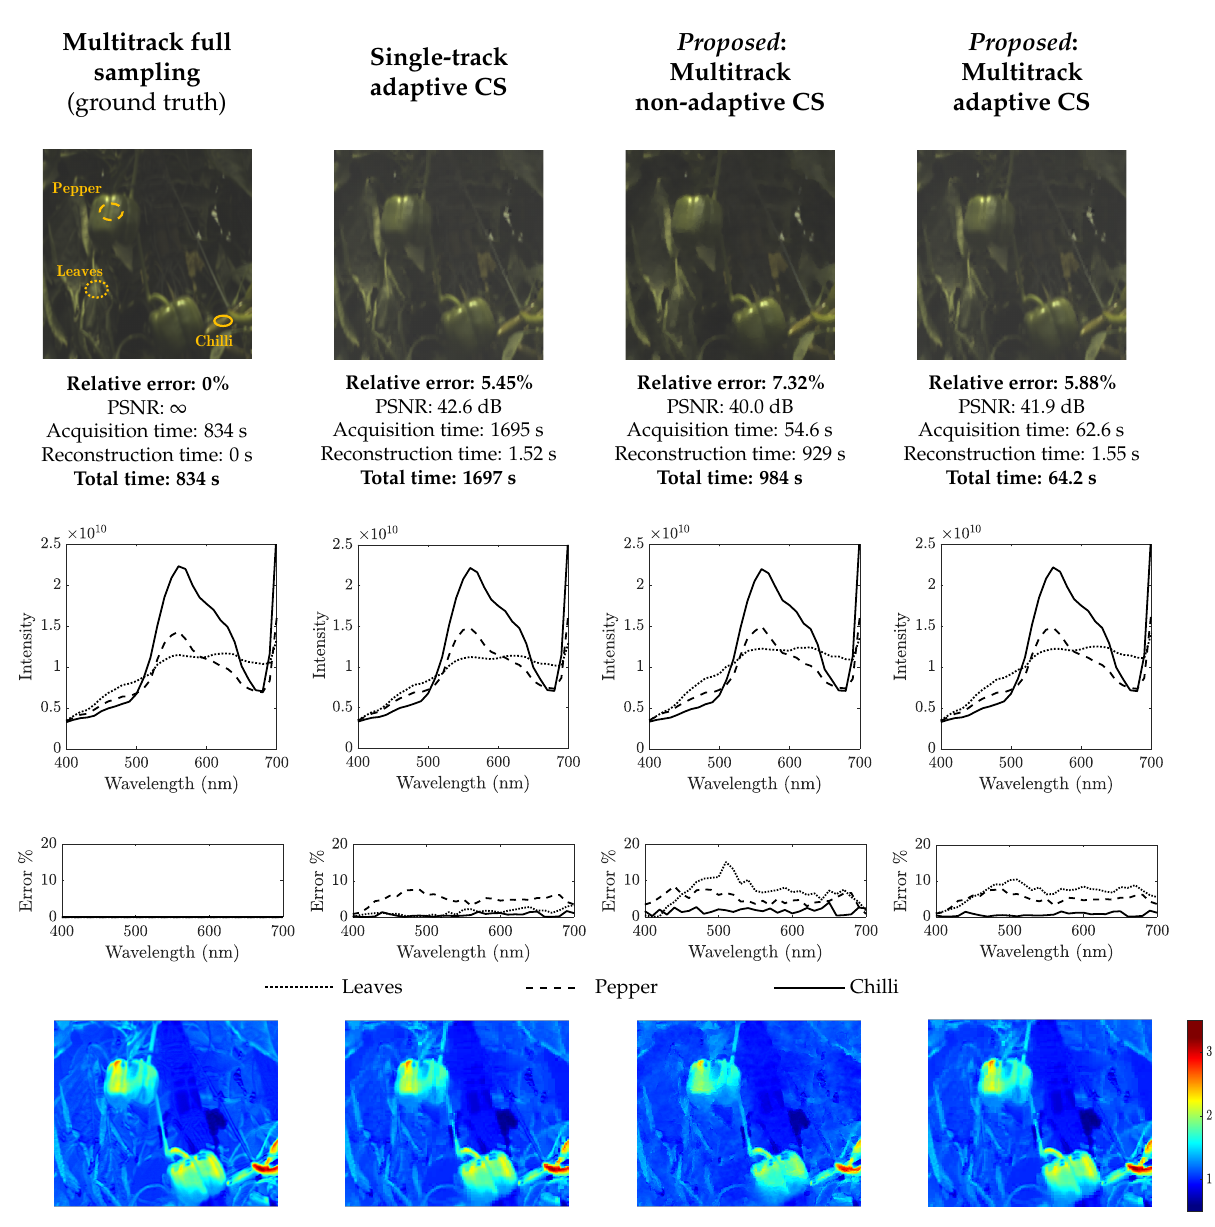
Figure 4. Simulations are carried out on the hyperspectral scene Green Peppers. The reconstruction results are presented for each of the methods tested. Pseudo-RGB versions of the reconstructed images are displayed in the first row. Reconstructed spectra are plotted in the second row. The dotted lines ( ) are from a point on the green leaves background; the dashed lines ( ) are from a point on the pepper near the top left corner; and the solid lines ( ) are from a point on a chilli at the bottom right corner, as indicated on the ground truth image. The third row shows the errors of the reconstructed spectra relative to the ground truth spectra. Finally, the fourth row displays the pixel-wise ratio of the spectral bands at 560 and 680